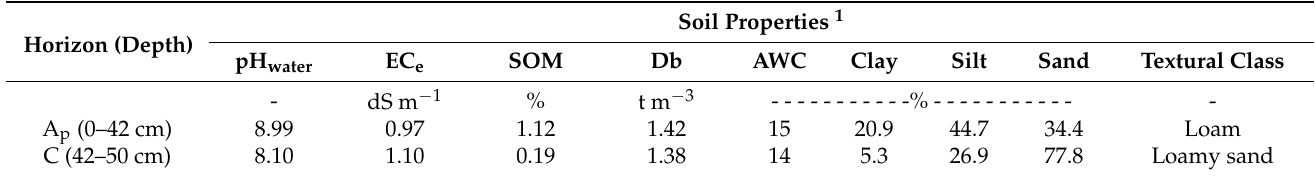
Soil Properties